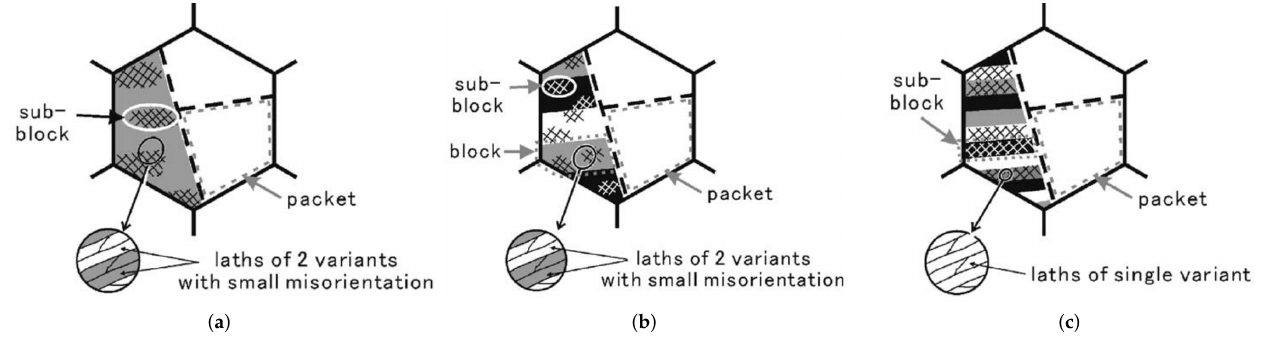
Figure 5. Bainitic packets of type-A ( a ), type-B ( b ), and type-C ( c ) in Fe-9Ni-C alloys. Taken from Furuhara et al. [58]. In ( c ), the originally labeled “block” is renamed to “sub-block”.